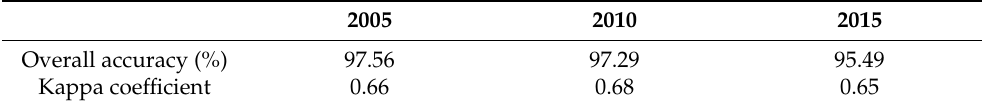
Table 1. Accuracy test comparing nighttime light based built-up area with the urban built-up area